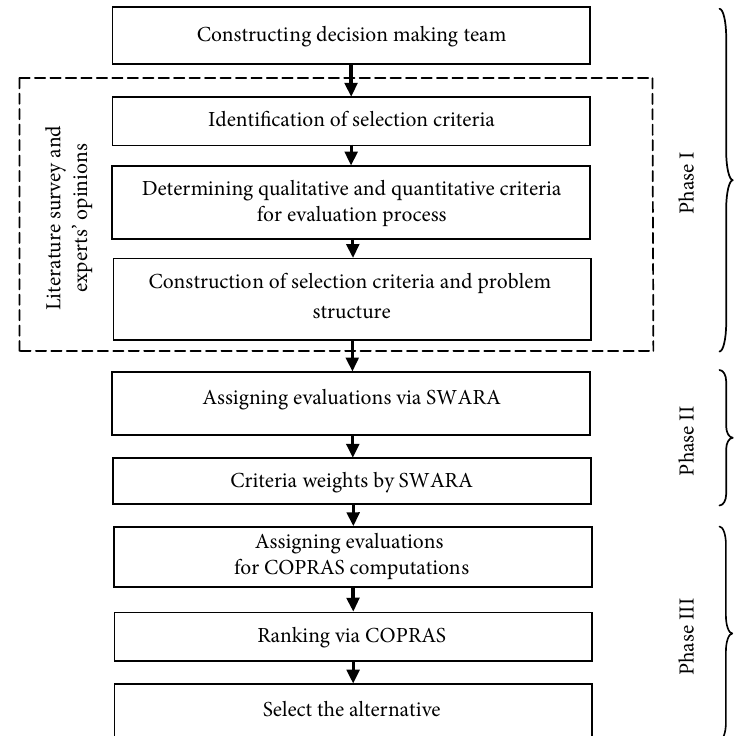
Fig. 1. The evaluation procedure of the proposed